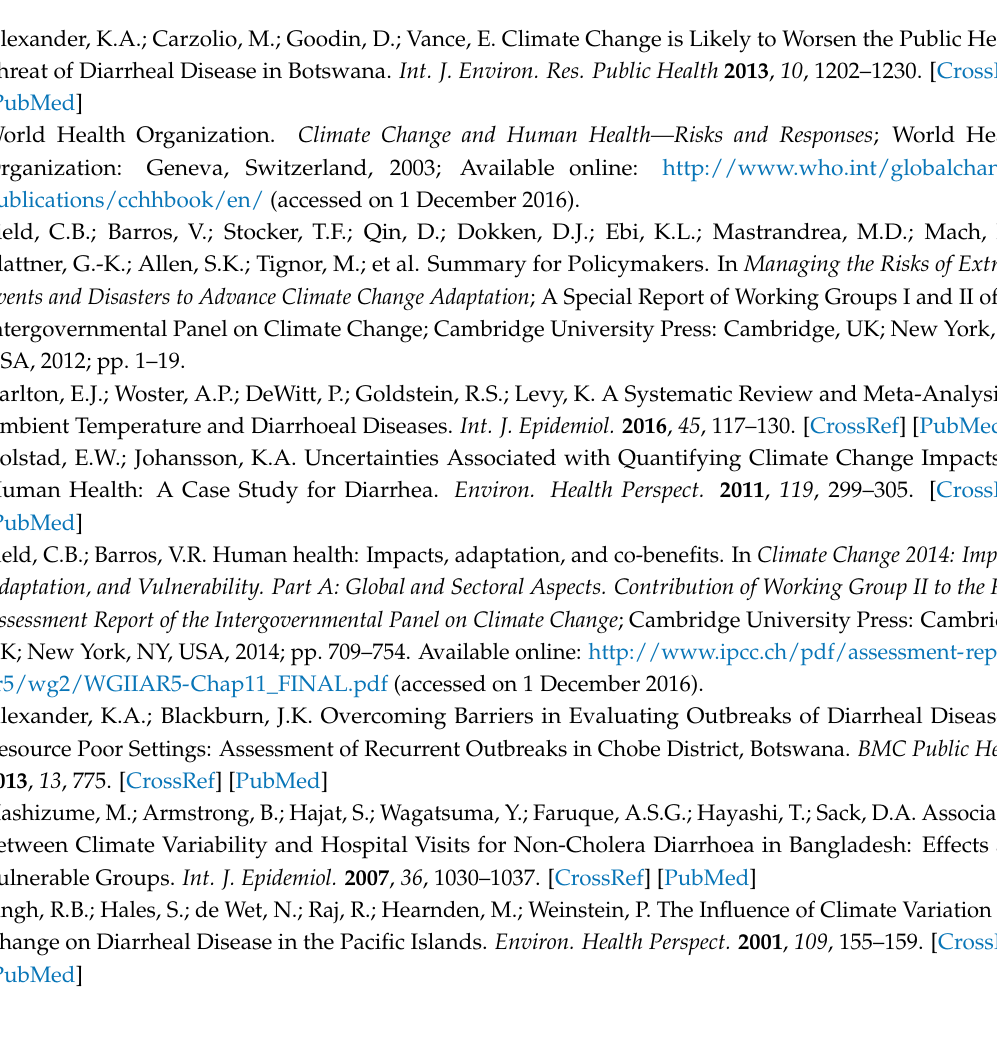
Figure S1: Annual diarrheal disease reporting percentages in Mozambique for the years 1989–2014, Figure S2: Regional seasonality of precipitation, Table S1: Mean values of weekly weather variables, nationally and by region, Table S2: Total observations ( n ), mean, and standard deviation of total cases reported each week nationally and regionally, by year, Figure S3: Average number of cases reported at the district-level each week, by week number, nationally, Figure S4: Regional seasonality of diarrheal disease in Mozambique, Table S3: Sensitivity analysis for the degree of smoothing in the temperature spline for the association between precipitation and diarrheal disease using the national model, Figure S5: Percent change (and 95% confidence intervals) of diarrheal disease associated with precipitation at the national level with increasing control of time, 0–12 knots per year (left to right). Figure S6: Percent change and 95% confidence intervals for diarrheal disease associated with precipitation at various lags of 0–8 weeks, controlling for time, average maximum temperature, and